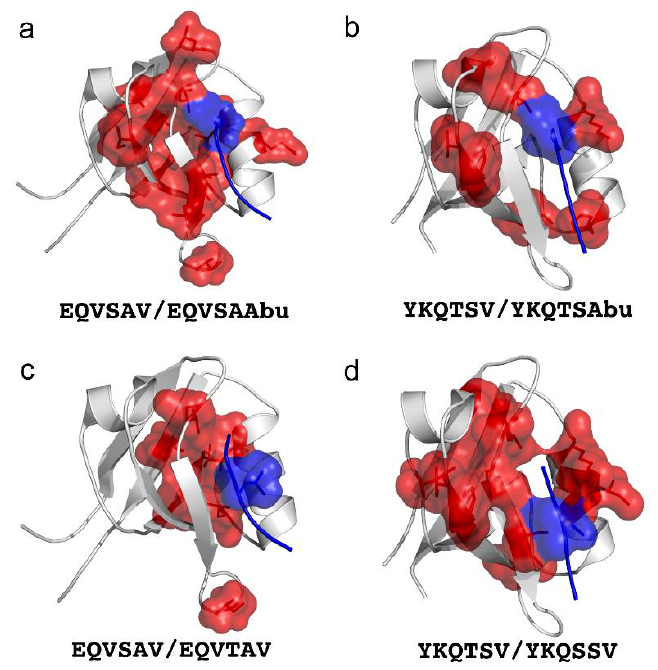
Figure 3. Graphic representation of the different allosteric networks of PDZ domain-ligand complexes of protein tyrosine phosphatase Basophil-like PDZ2 ( a and c panels) and PSD-95 PDZ3 ( b and d panels) with their natural ligand (showed below each panel). All the mutated residues are represented as spheres both in the ligand (blue) and in the PDZ domain (red). The peptide ligand mutations Val → Abu (deletion of a γ -methyl group from Val), Ser → Thr or Thr → Ser were chosen because they interact with the binding pocket of PDZ